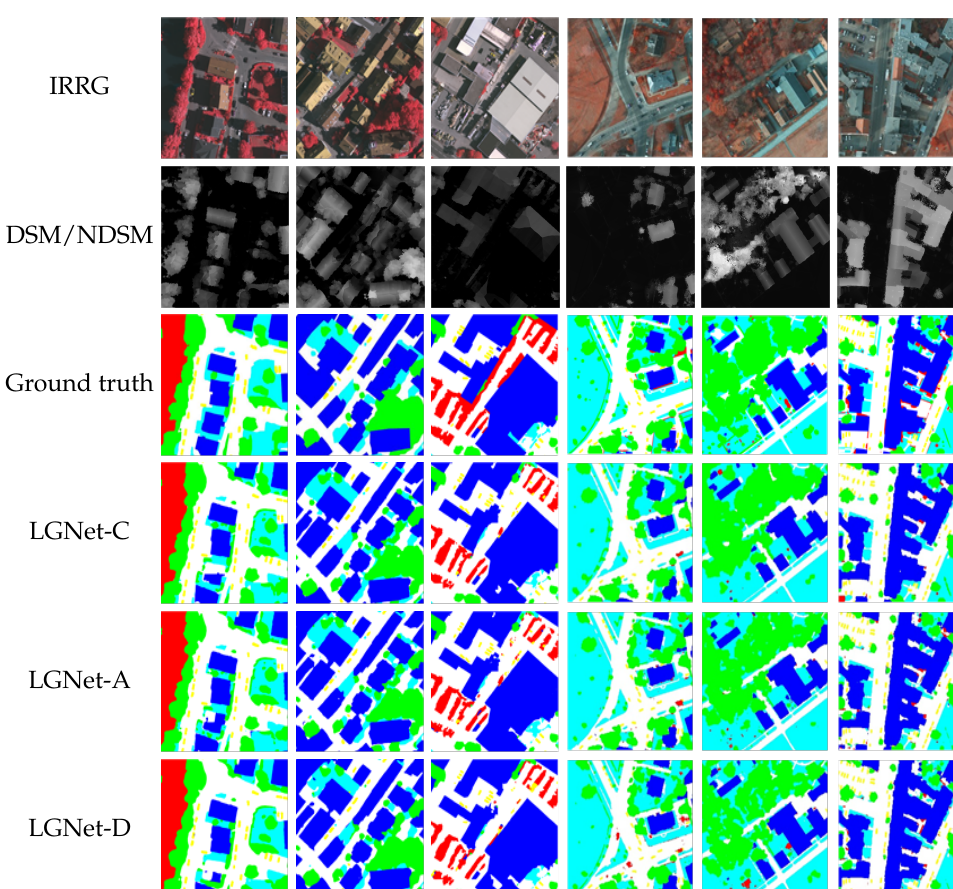
Figure 7. Some samples of the LGNet-C, LGNet-A and LGNet-D results on the ISPRS Vaihingen and Potsdam